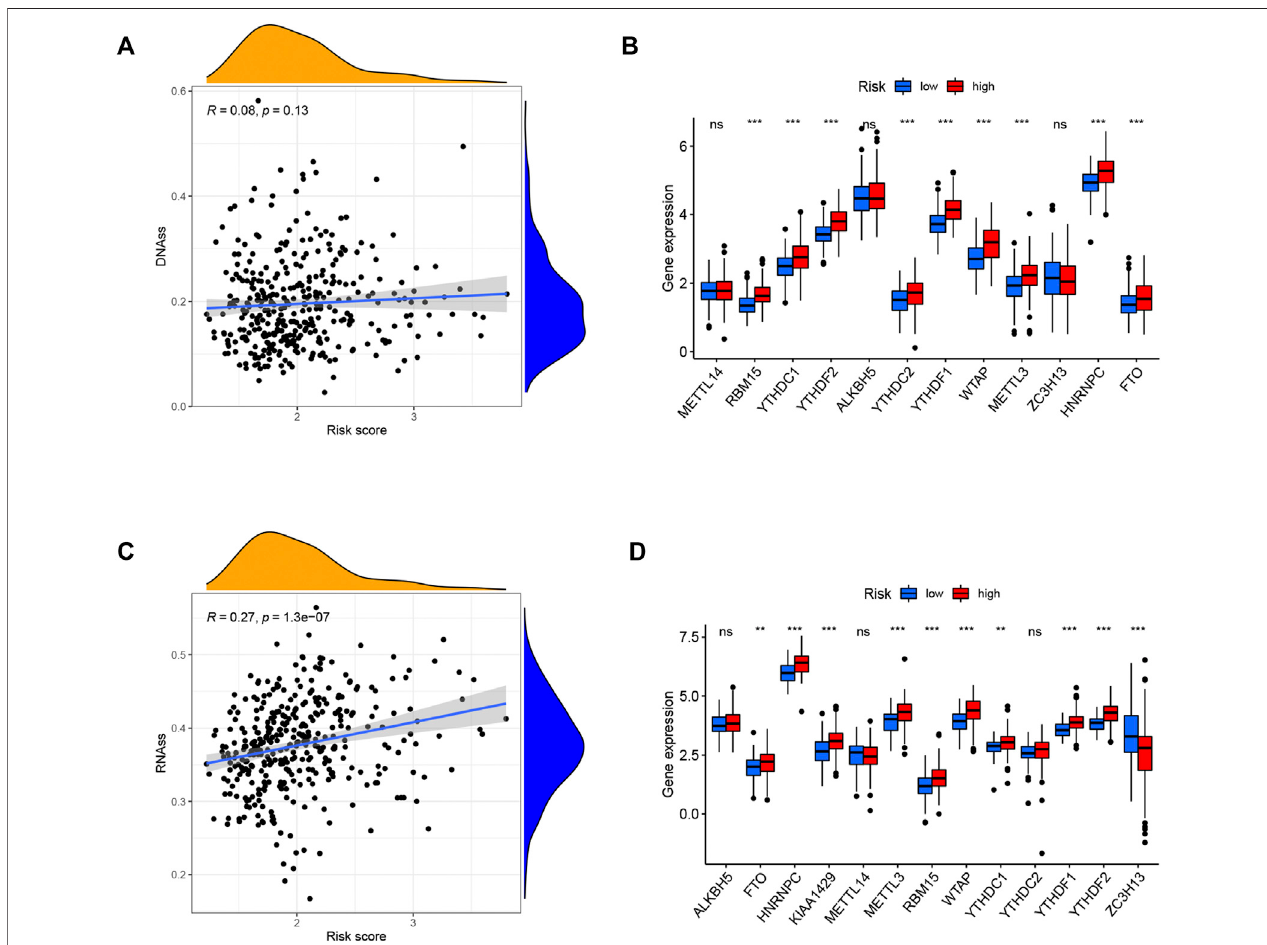
FIGURE 10 | Potential role of risk signature in HCC tumor stemness and m6A-related genes. Associations between risk signature and DNAss (A) , RNAss (C) . Comparison of the m6A-related genes between different risk groups in the TCGA cohort (B) and ICGC cohort (D) .